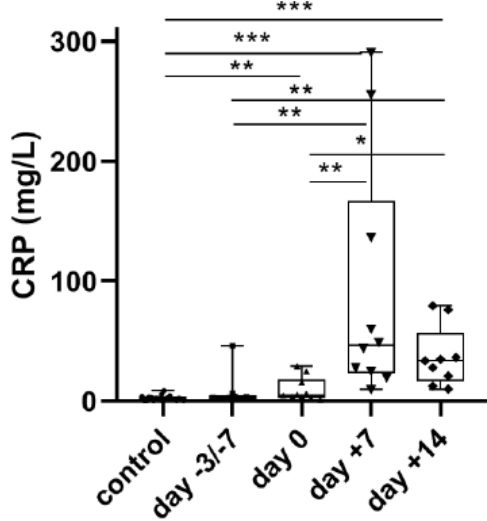
Figure 5. Changes in serum CRP levels at four stages of autologous peripheral stem cell transplanta- tion (APSCT). The start of conditioning therapy (day − 3 in patients with multiple myeloma receiving melphalan and day − 7 in patients with lymphoma receiving BEAM conditioning) was defined as the first day of samplings. Values are expressed as sample means. The small black configurations (dots, triangles, squares, etc.) are individual data points, and the box plots denotes the data mean. Error bars represent the standard deviations which describe average difference between the data points and their mean. (* p < 0.05, ** p < 0.01, *** p <